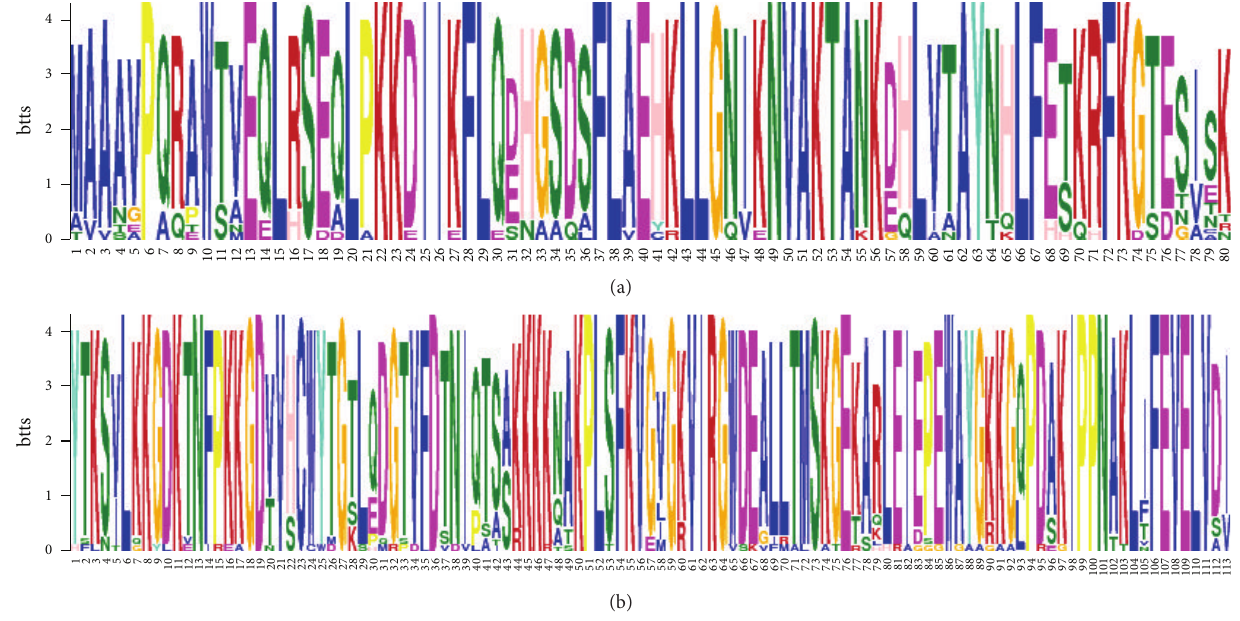
Figure 5: Sequence logos (MEME LOGOs) of conserved motifs identified in vertebrate